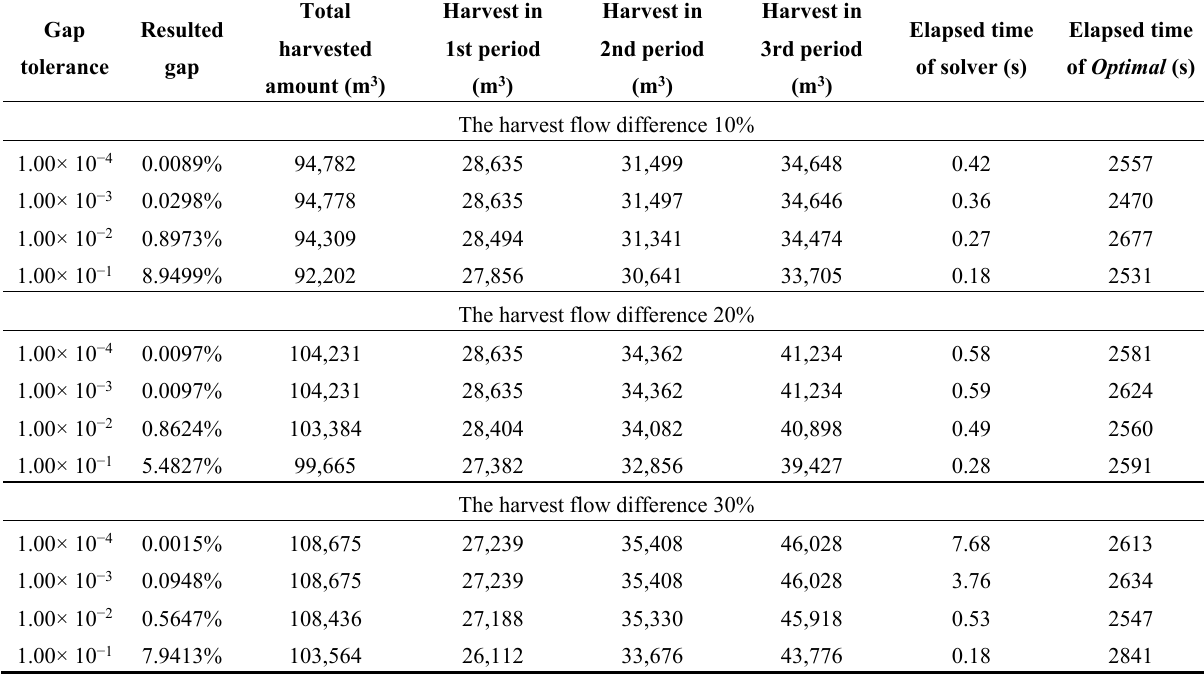
Table 3. The harvest schedule for three planning periods for different sub-variants of ComP-N according to gap